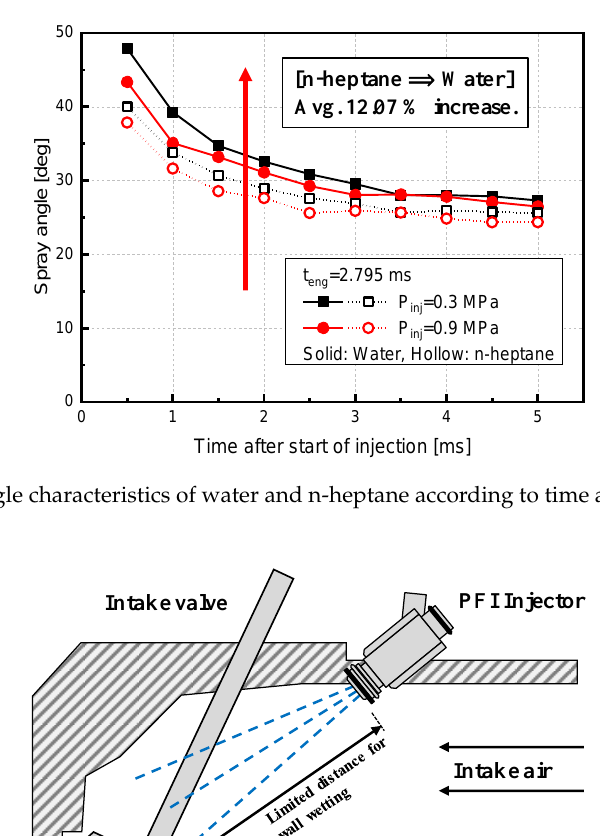
Figure 8. Schematic diagram of intake port in PFI system and definition of limited distance for wall wetting.